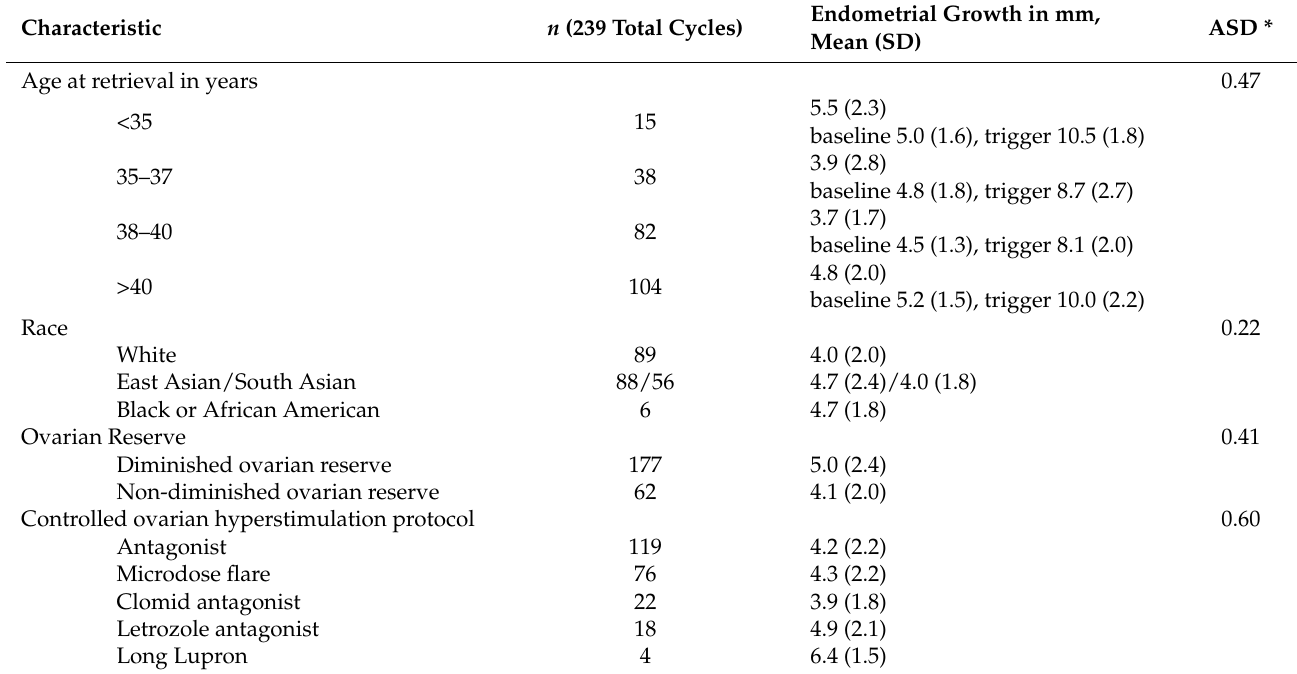
Table 2. Univariate analyses of mean increase in endometrial thickness.